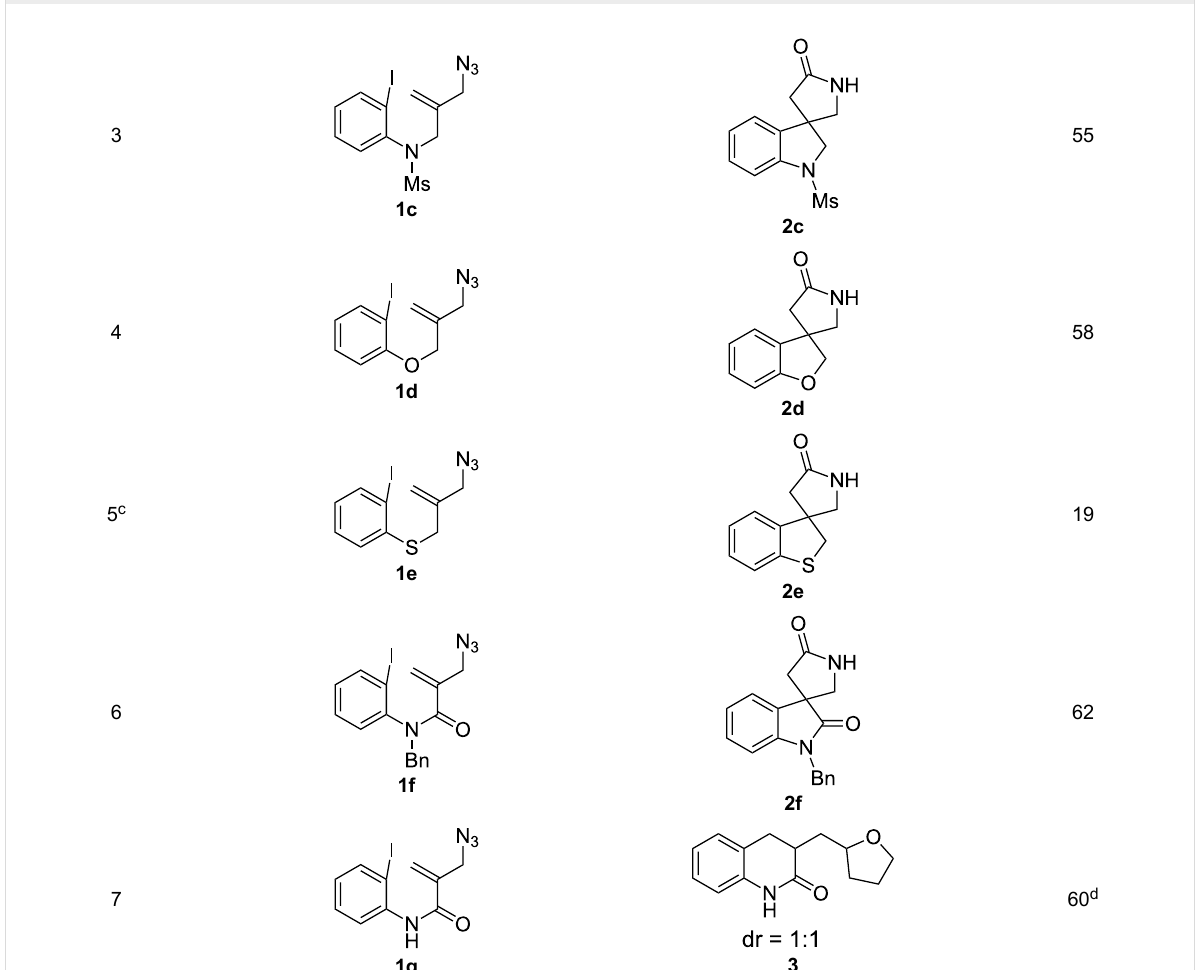
Table 1: Synthesis of 4,4-spirocyclic γ -lactams 2 by tandem radical spirocyclization of 1 with CO. a